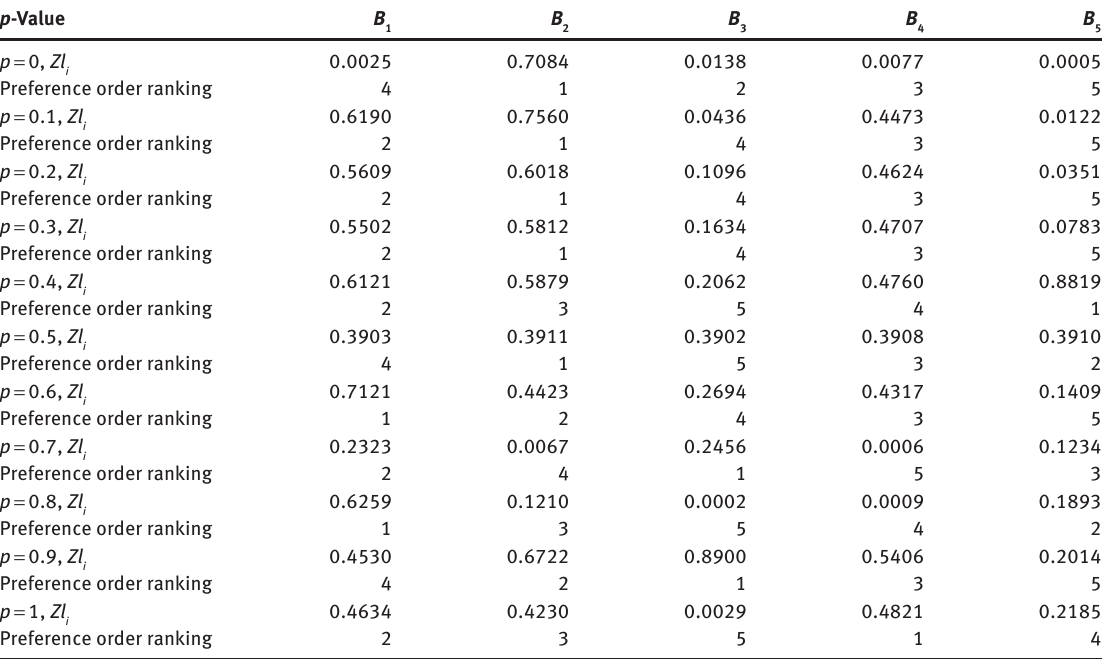
Table 19: Different Values of p and Preference Order Ranking by the Proposed Cubic Fuzzy Multi-Attribute Group Decision- Making Model.